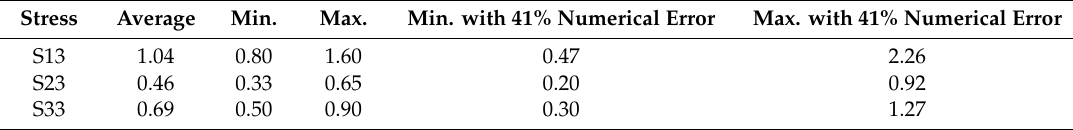
Table 14. Summary of the stress limit criteria calculated by the numerical model with and without numerical